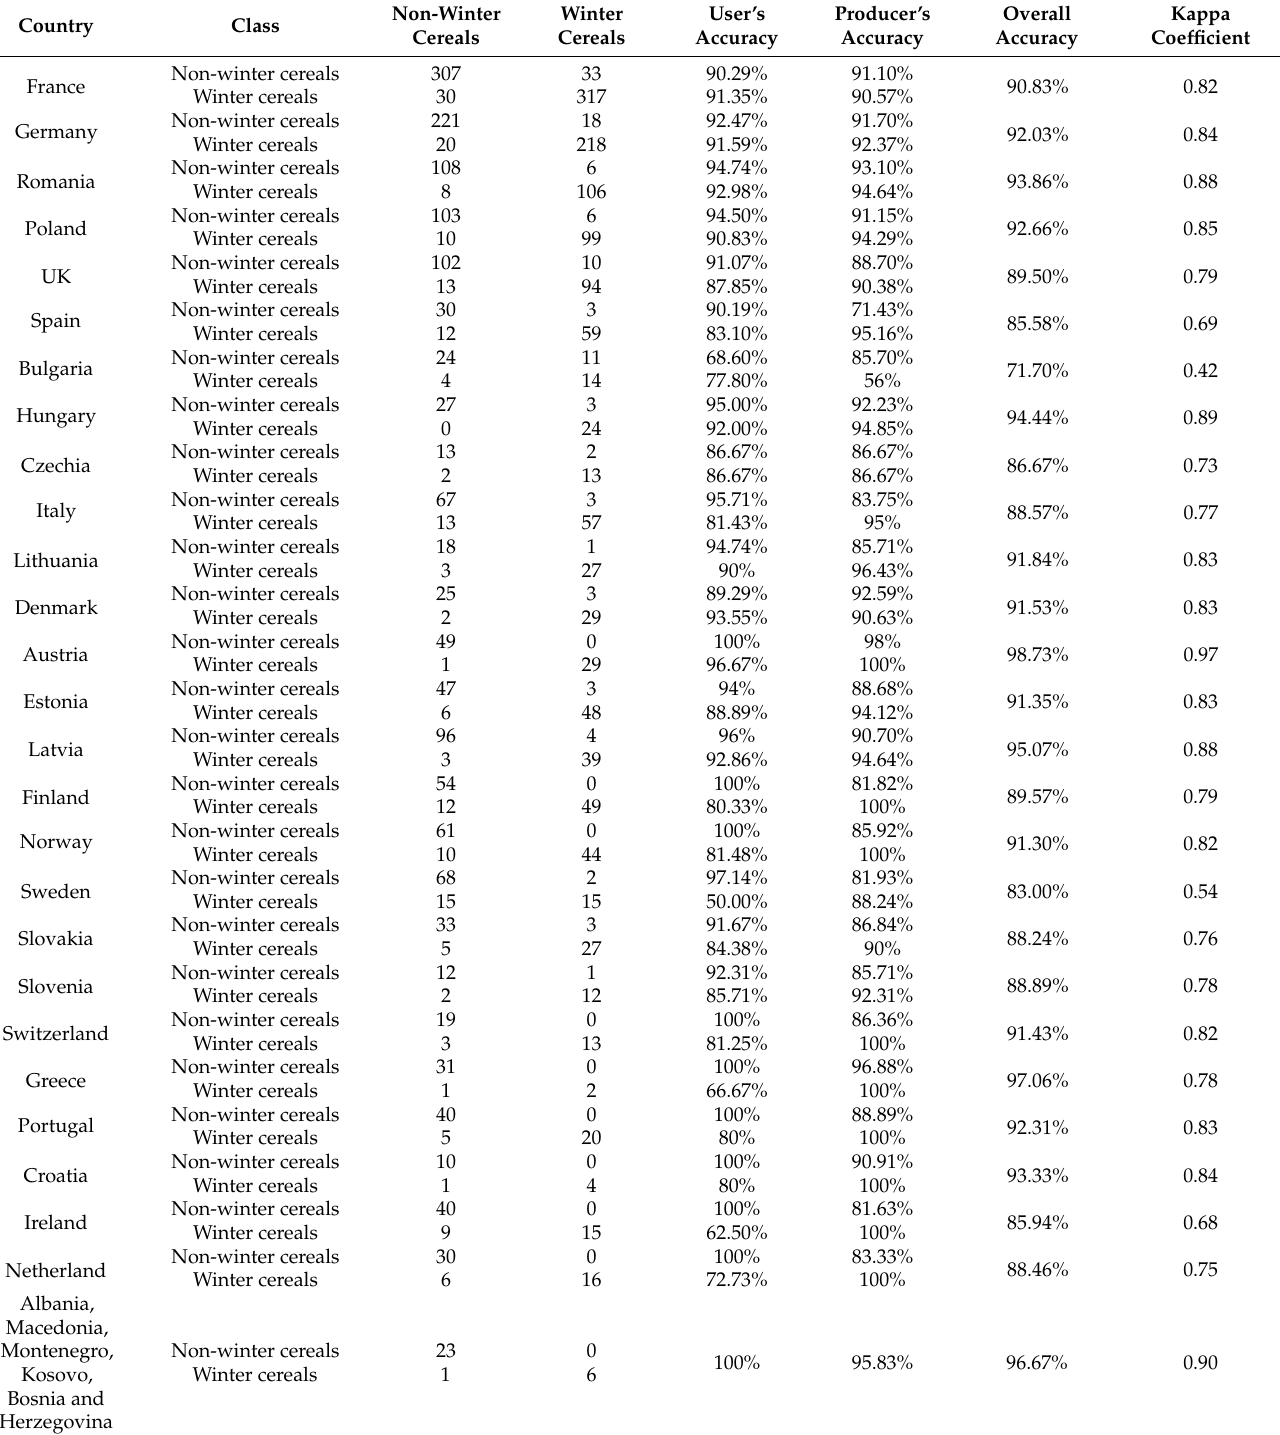
Table 2. The confusion matrix of the final winter cereal maps for 32 countries in Europe in